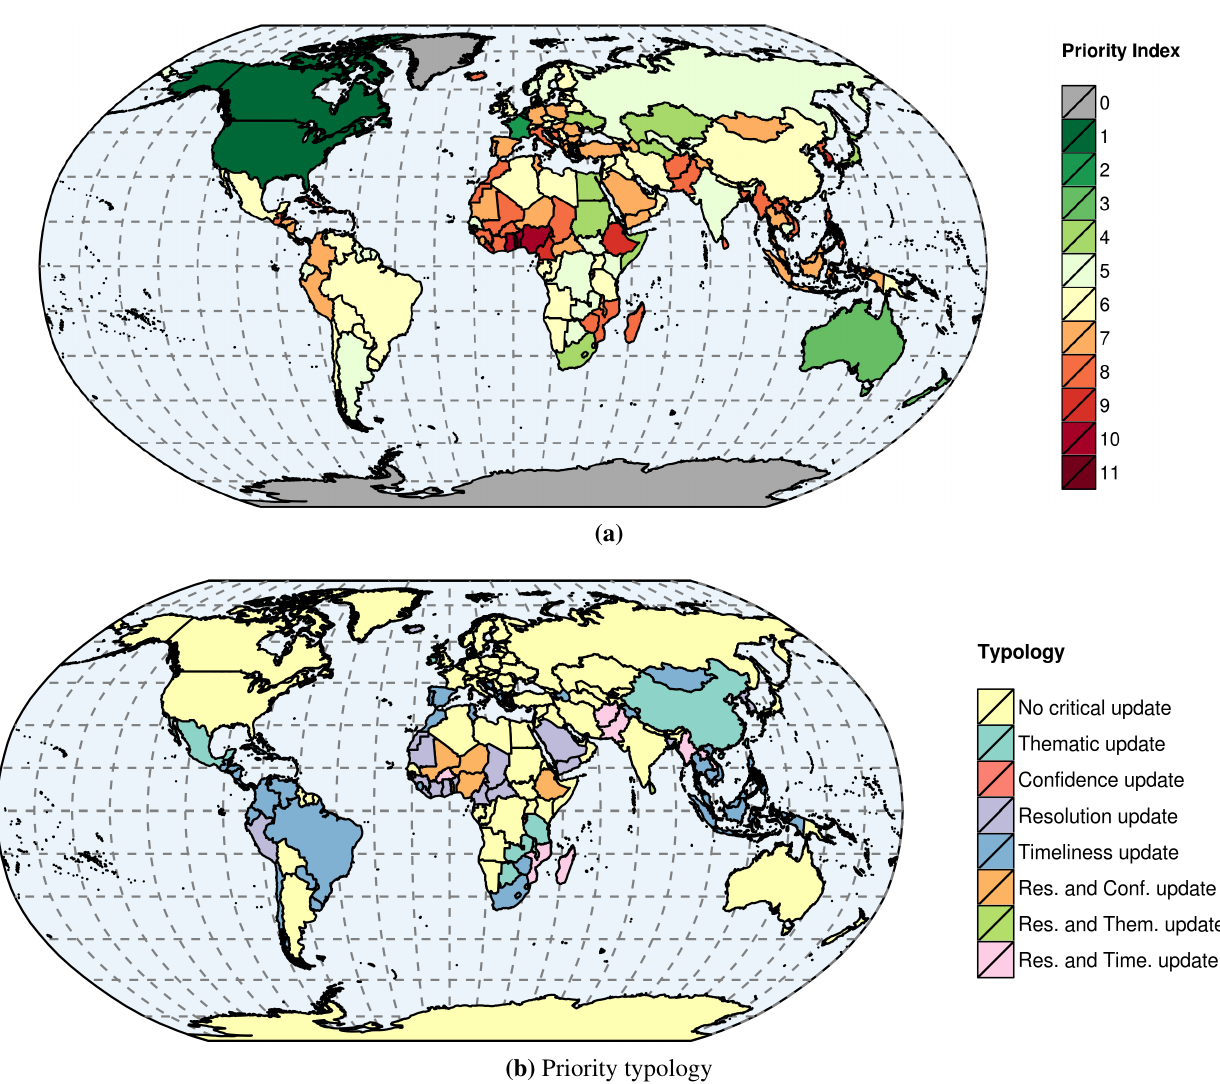
Figure 4. ( a ) Priority indicator map and ( b ) its update typology. Areas with a high priority index (reddish shades) characterize priority areas for cropland mapping, whereas areas with low scores correspond to an accurate and precise current mapping (greenish shades). West Africa, Ethiopia and Southeast Asia (Indonesia) clearly appear as priority areas for cropland